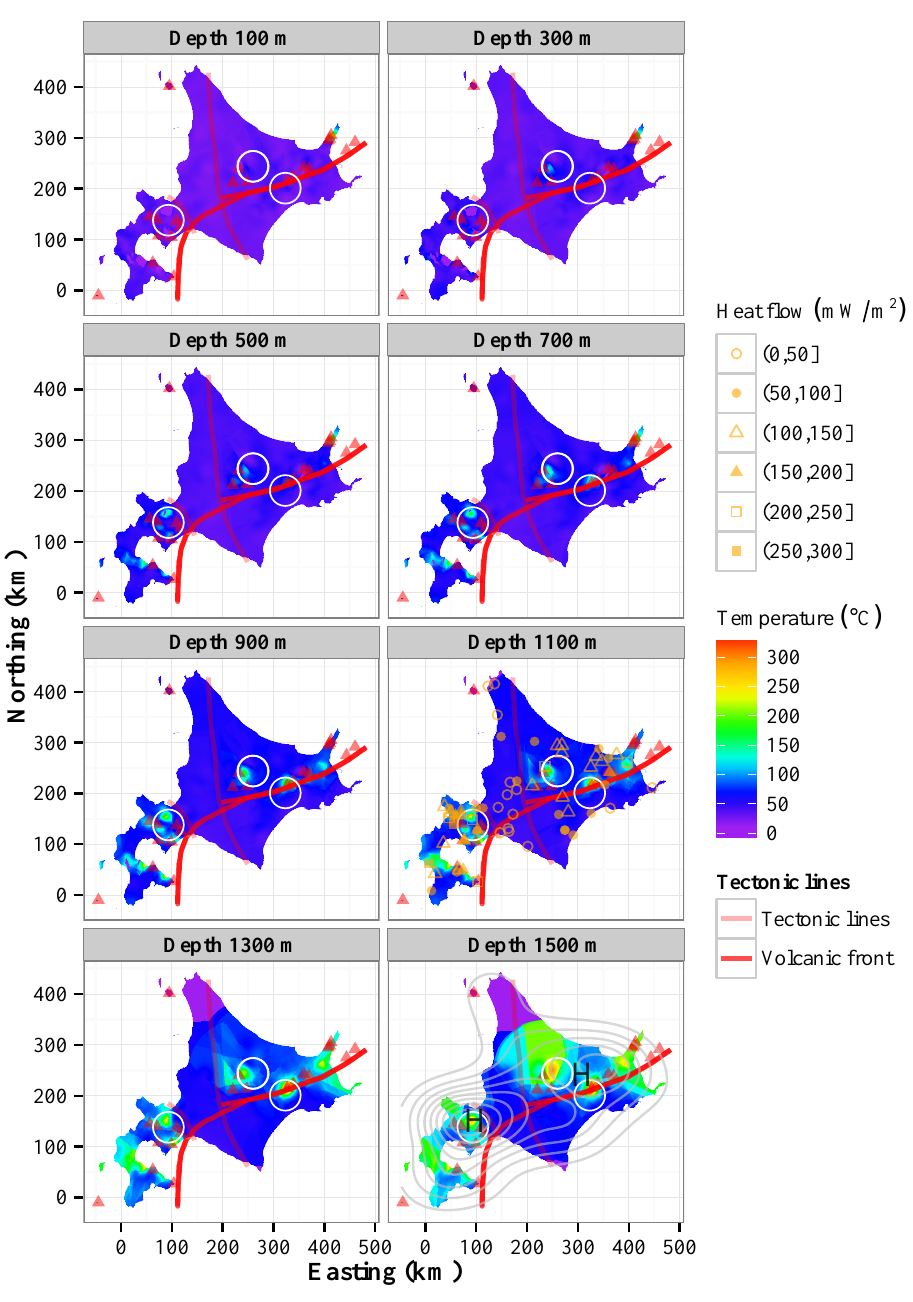
Figure 9. Temperature distribution at the same depth based on temperature logging data and Kriging with External Drift or trend (KED) from 100 to 1500 m b.s.l. at 200 m intervals, superimposed on the heat flow data modified from Tanaka et al . (2004) [48,49] (at 1100 m), and their contour map by weighted kernel density (at 1500 m). Purple at depths deeper than 1100 m b.s.l indicates that the area is outside the calculation region due to insufficient temperature data for KED. Red triangles and white circles indicate active volcanoes and local high temperature zones,